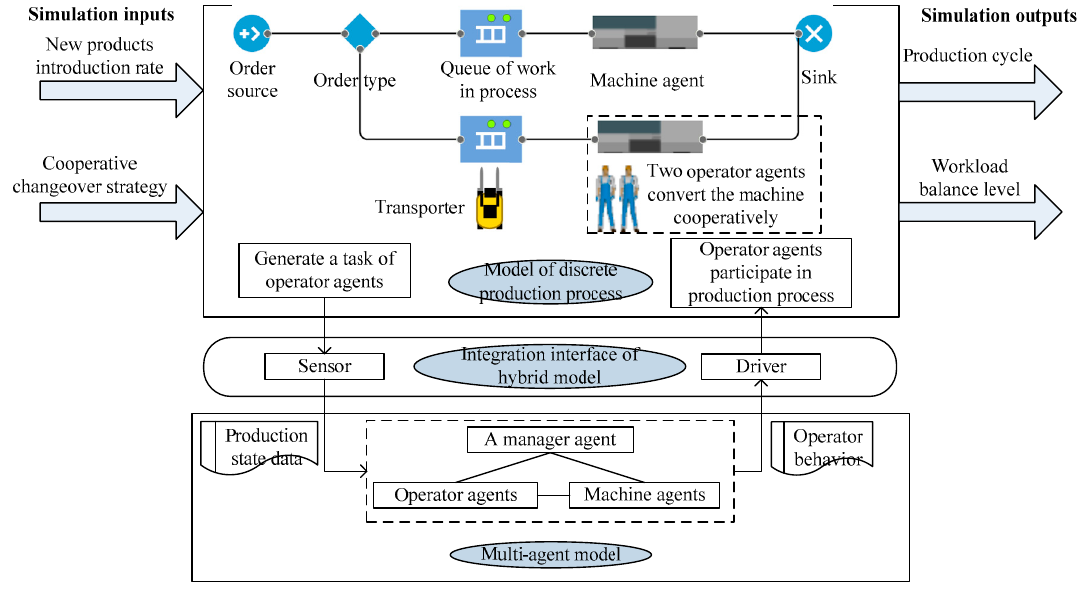
Figure 1. Frame of hybrid simulation model.